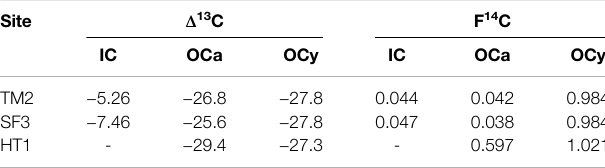
TABLE 2 | δ 13 C and F 14 C values of the sedimentary C sources used in the mass balance calculation. Site Δ 13